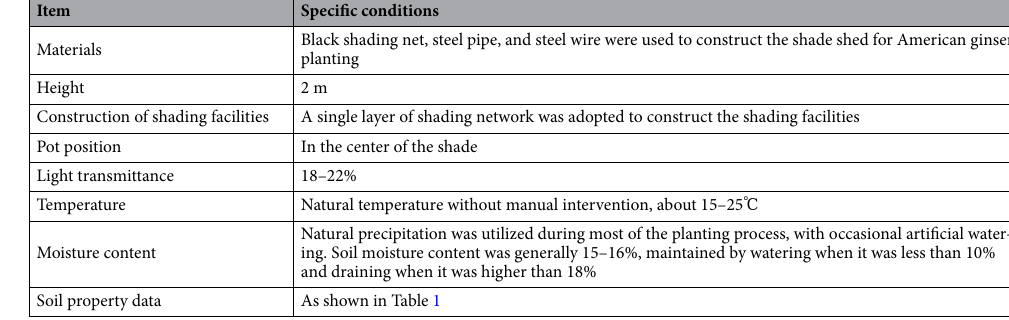
Table 3. Materials used and environmental conditions of artificial shading facilities. American ginseng is geo- authentic, and the climate of Wendeng area is suitable for its